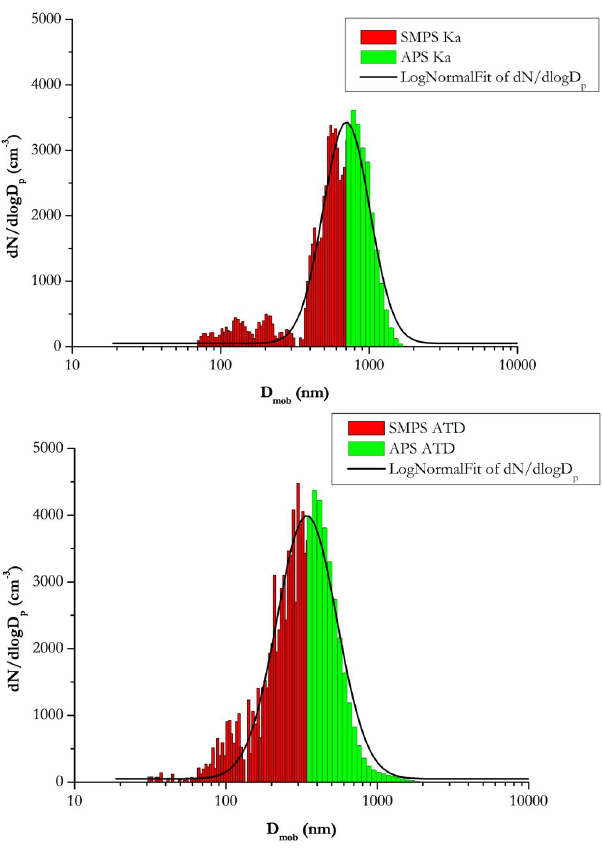
Fig. 3. Representative surface area distributions for Ka (top) and ATD (bottom) of suspended dust particles in aerosol tank recorded with an SMPS and APS simultaneously. We note that IN counters sampled through a 1µm impactor necessitating the use of surface distributions of less than 1.14µm aerodynamic diameters for n s (T )